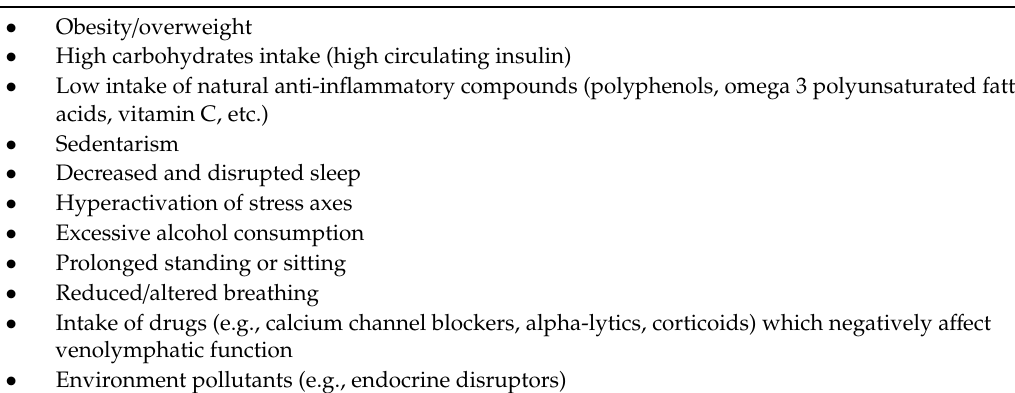
Table 4. Epigenetic factors which may deteriorate chronic venous and lymphatic